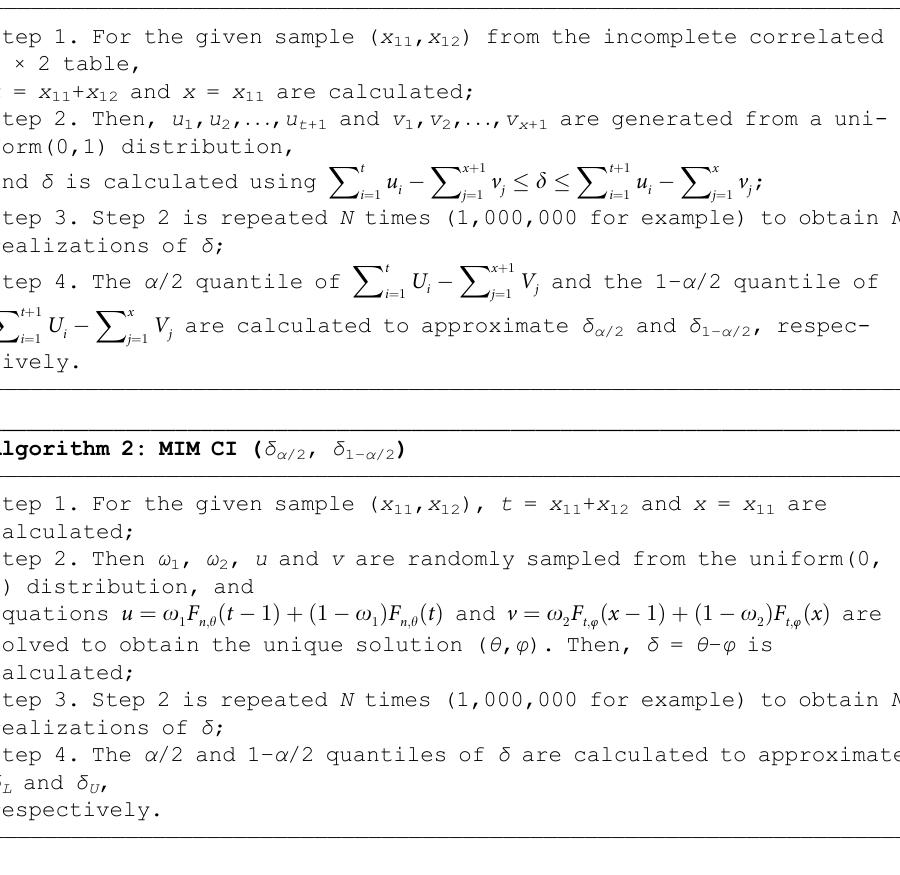
Algorithm 1: Fiducial CI ( δ α /2 , δ 1− α /2 )